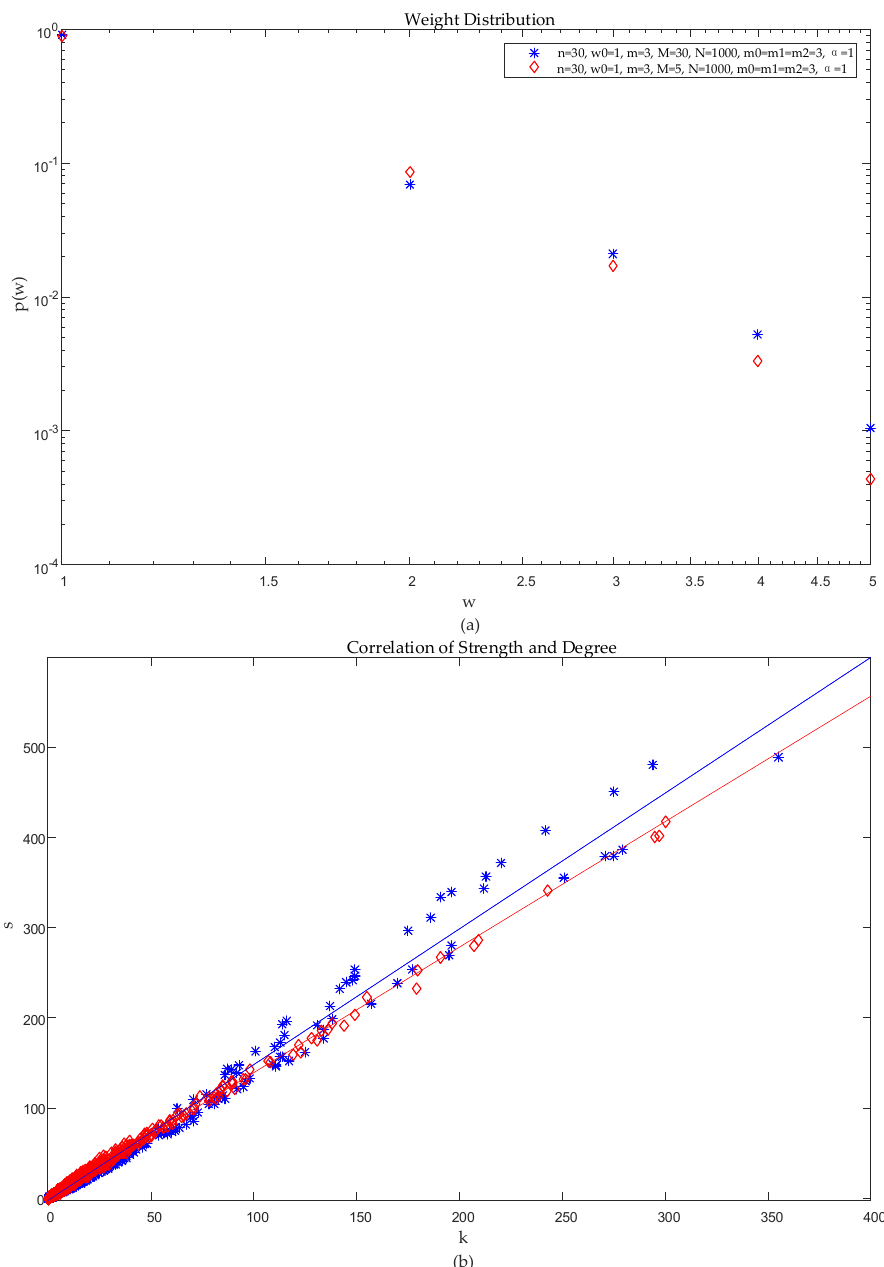
Figure 7. Analysis of the influence of local-world M on network structure performance: ( a ) Distribution of edge weights; ( b ) Distribution of the correlation of strength and Degree.